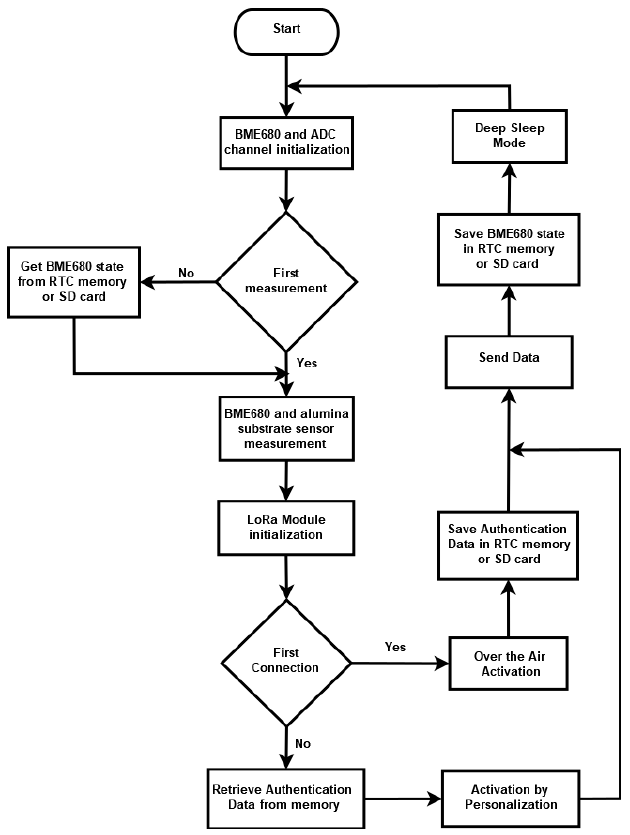
Figure 4. Flow diagram from the program running in the nodes.